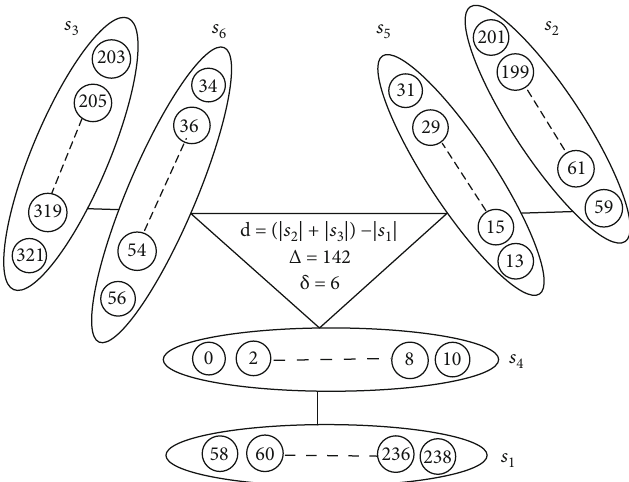
Figure 2: L ð 3, 2, 1 Þ labeling of Γ of order η = 7 × 11 × 13